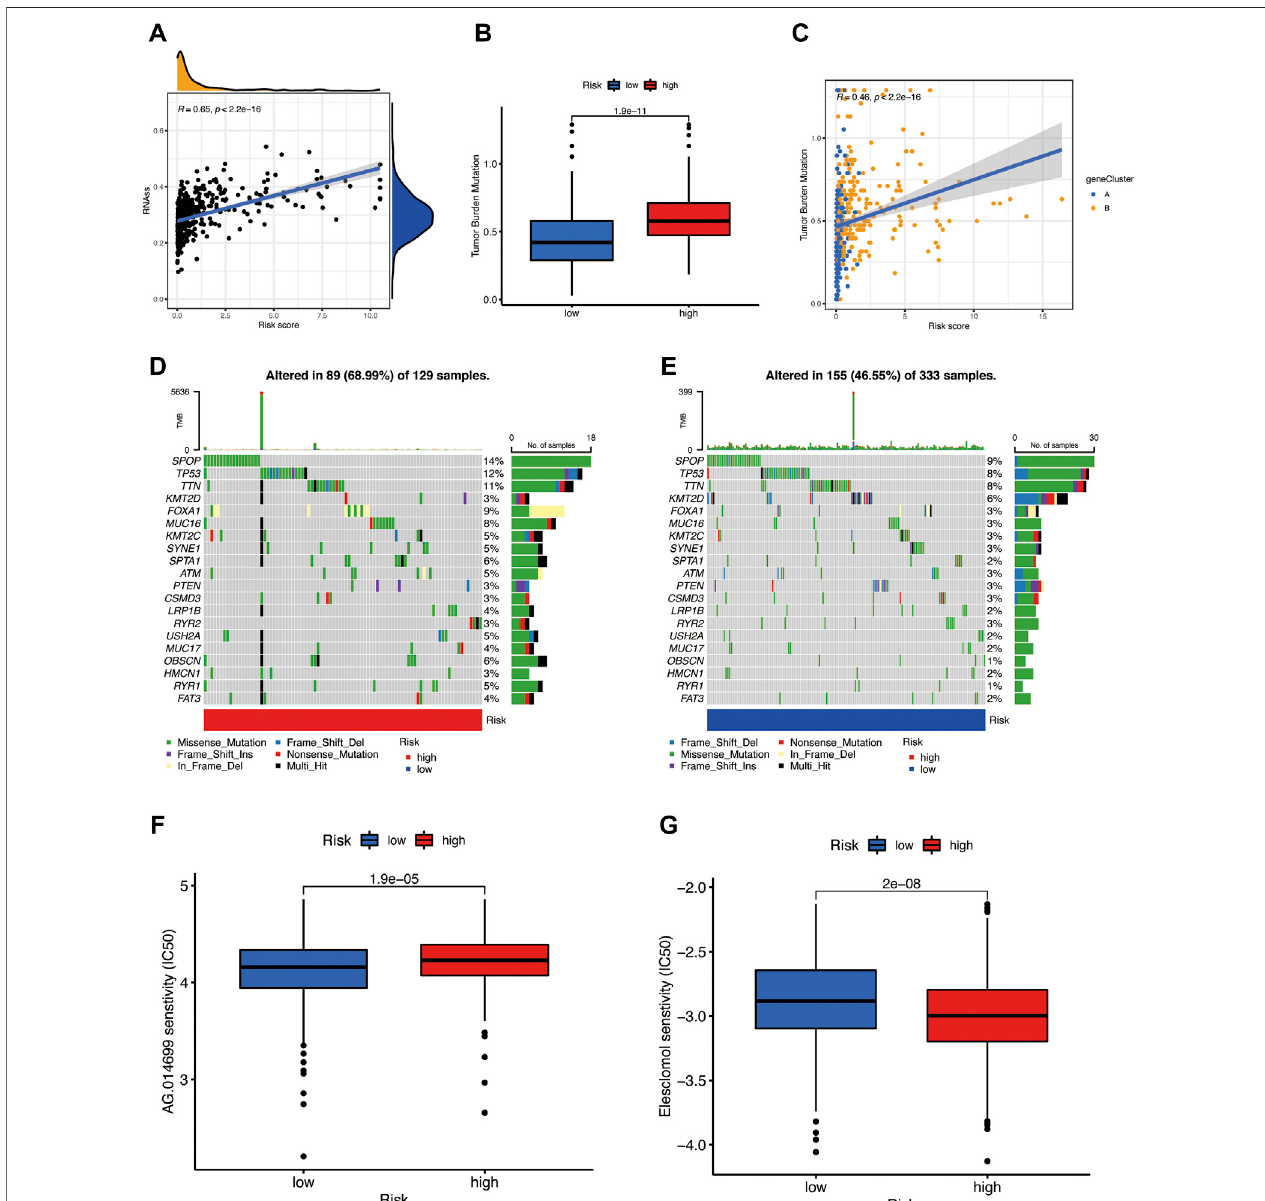
FIGURE 8 | (A) The risk score has a positive relationship with the CSC index. (B,C) Boxplot and Spearman correlation reveal that the high-risk group has a higher TMErate. (D) Somaticmutationofpyroptosis-relatedgenesinahigh-riskgroup. (E) SomaticmutationofPRGsinthelow-riskgroup. (F) Rucaparibissensitiveindifferent risk groups. (G) Elesclomol is sensitive in different risk